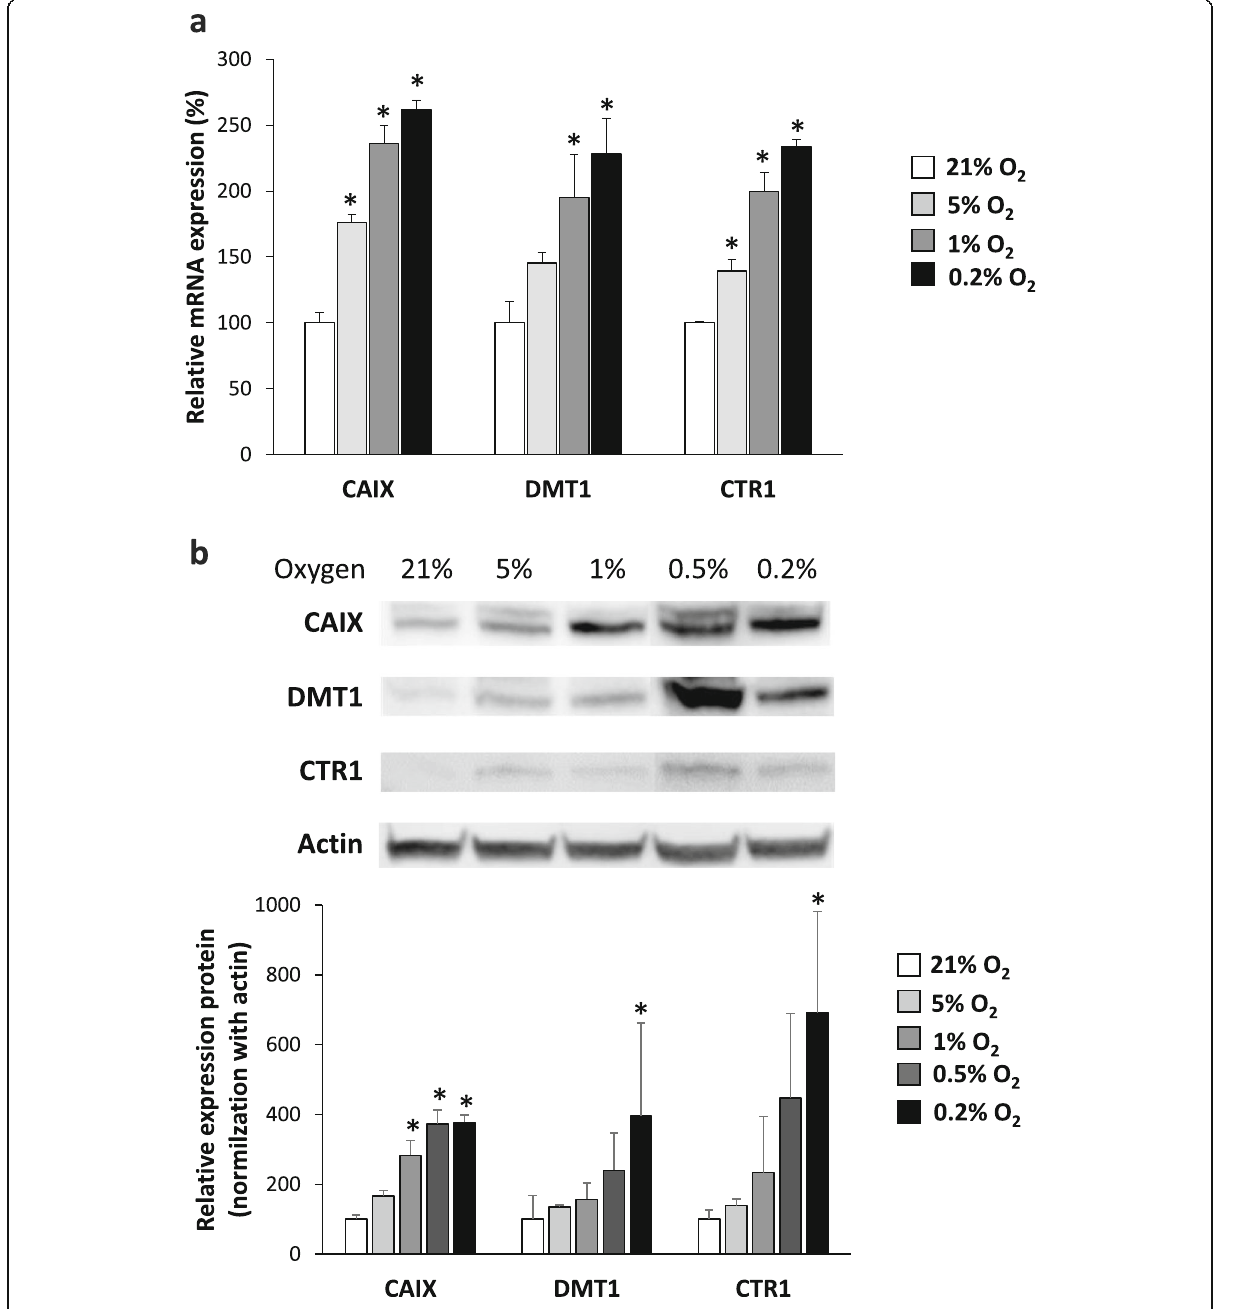
Fig. 6 Expression of copper transporters, CTR1 and DMT1, in hypoxia. Quantification of expression of CTR1 and DMT1 at mRNA ( a ) or protein levels ( b ) from cells exposed for 24 h in hypoxic conditions (5%, 1%, 0.5%, and 0.2% O 2 ) relative to normoxia (21% O 2 ). CAIX expression was used as positive hypoxic control. Mean ± SD, n = 3 different cell cultures per condition. Tukey ’ s HSD test after significant one-way ANOVA: * p <